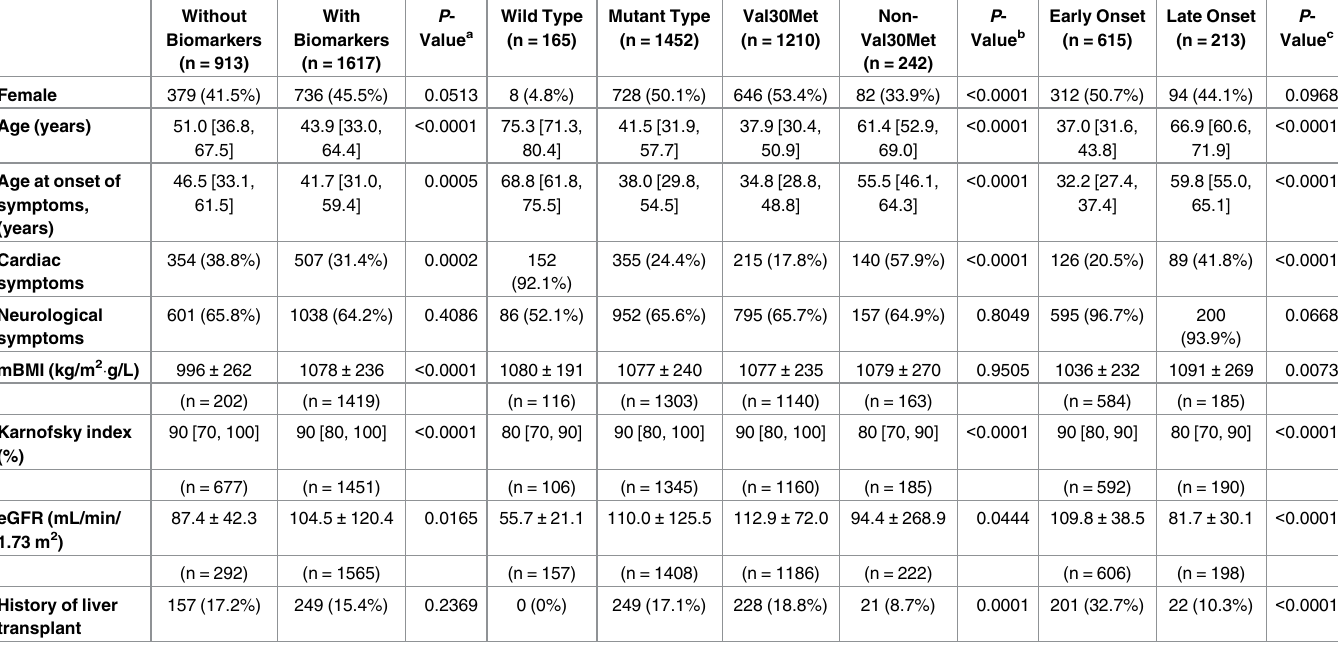
Table 1. Demographics of symptomatic patients. Without